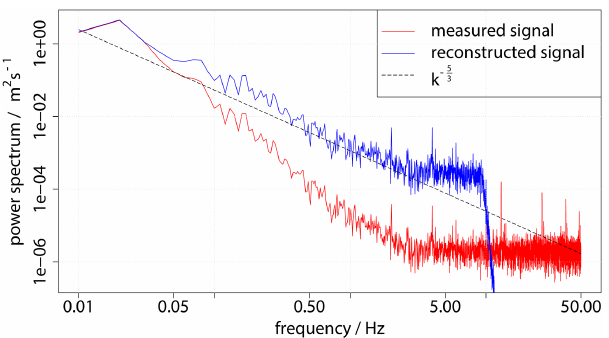
Figure 9. Power spectrum of relative humidity before and after cor- rection. The number of layers in the sensor model is set to N = 40. From the vertical profile, the diffusion constant was found to be D = 0.1µm 2 s − 1 . The spectrum is averaged over five flight